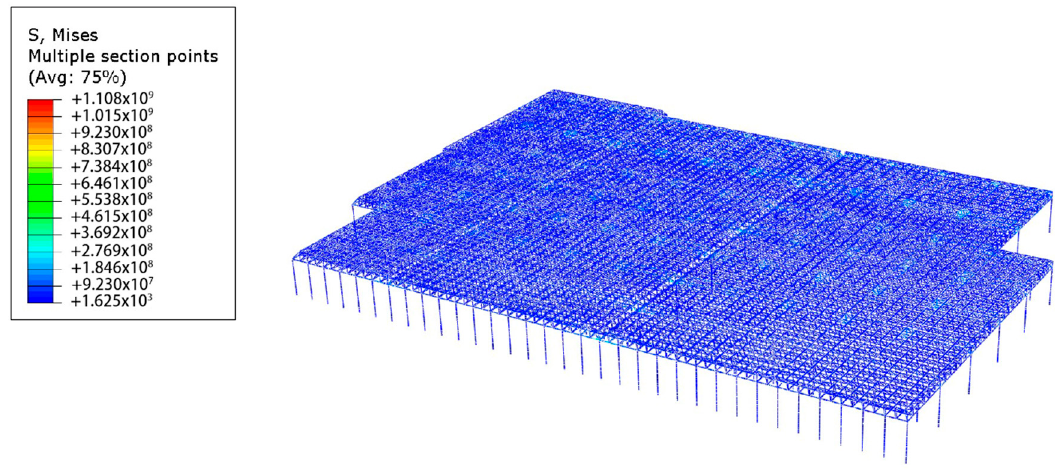
Figure 17. Stresses due to load and thermal effects in the space frame and steel-reinforced concrete column system.